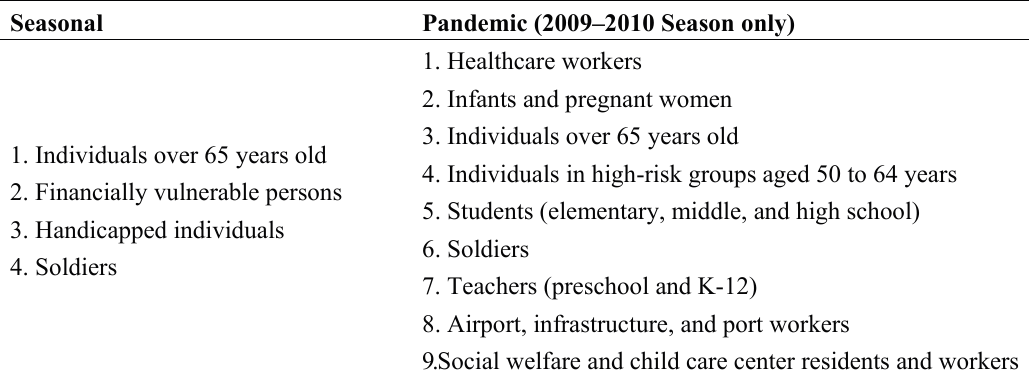
Table 1. Priority groups for seasonal and pandemic influenza